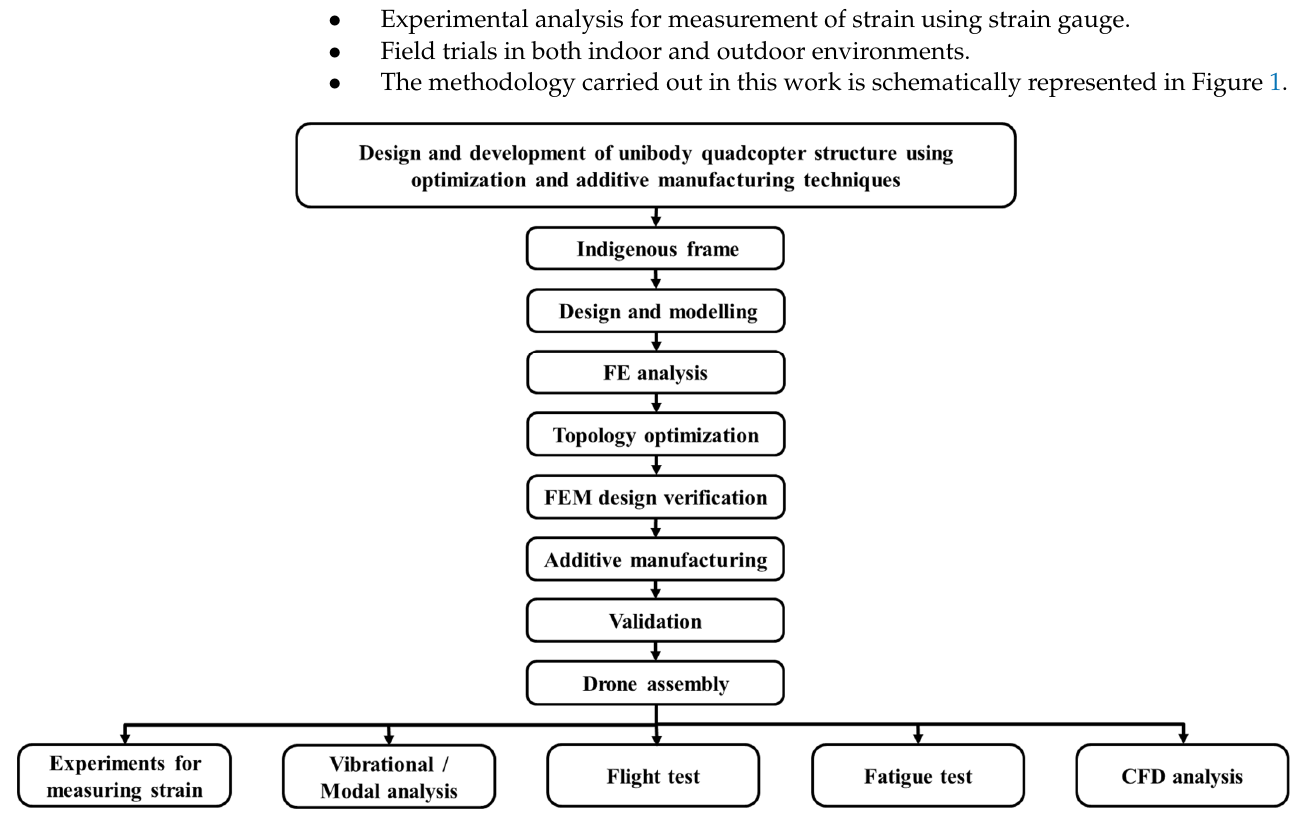
Figure 1. Overview of research methodology.